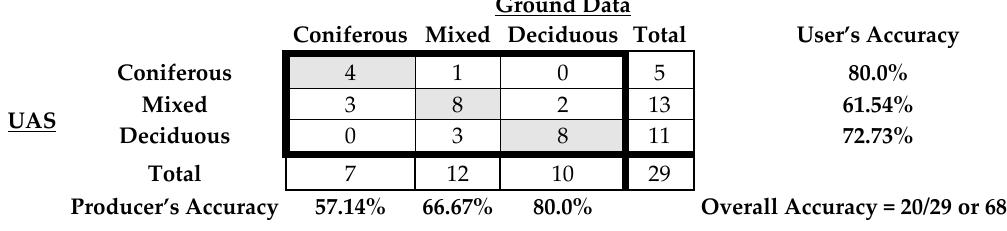
Table 3. Stratified random sampling PBC thematic map error matrix. Ground (reference) data are Table 4. CFI plot-registered PBC thematic map error matrix. Ground (reference) data are represented represented by the CFI plots and Unmanned Aerial Systems (UAS) data are derived from the by the CFI plots and Unmanned Aerial Systems (UAS) data are derived from the corresponding corresponding orthomosaic. orthomosaic.